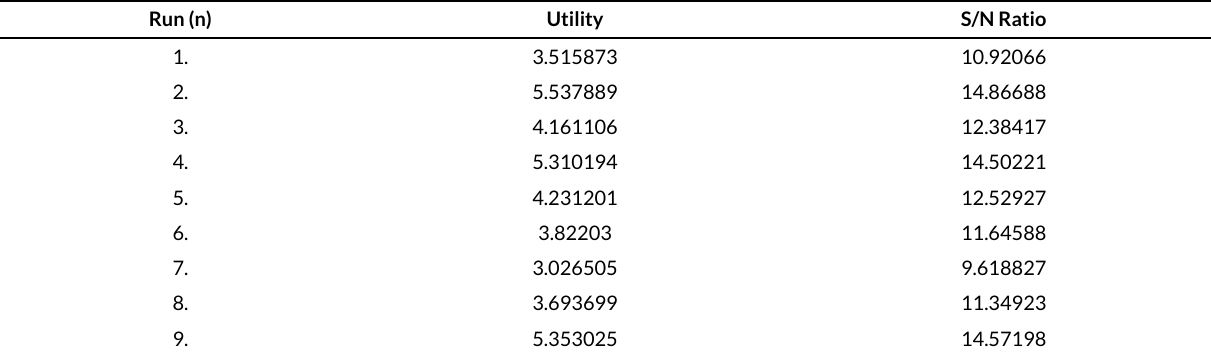
TABLE 5. UTILITY VALUES, S/N RATIOS AT VARIOUS